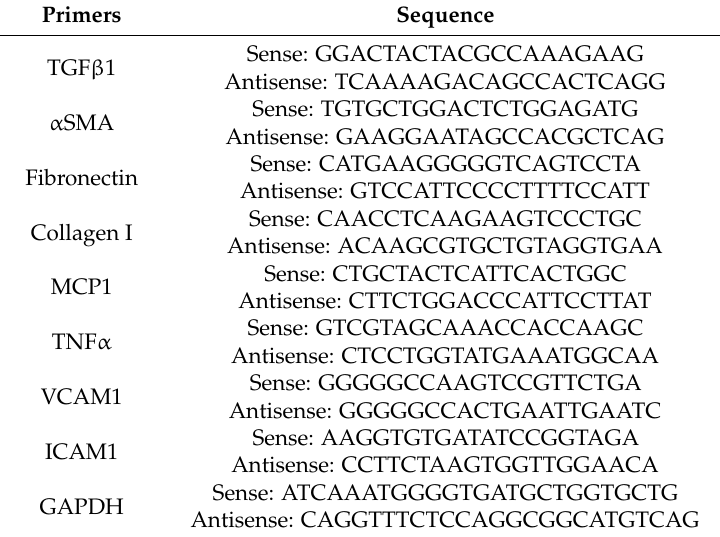
Table 3. Primer sequences for real-time